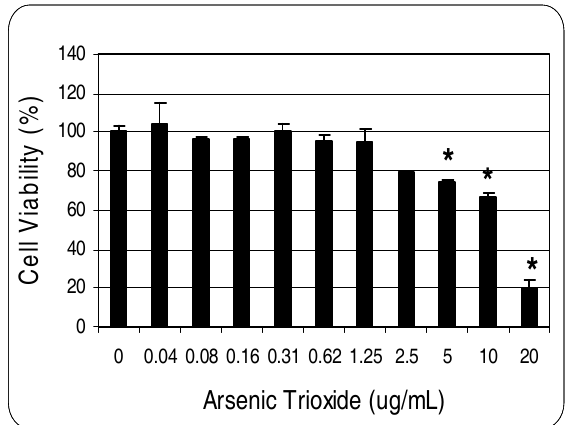
Figure 4: Time-response relationship with regard to the cytotoxicity of arsenic trioxide to human leukemia (HL- 60) cells. HL-60 cells were cultured with different doses of arsenic trioxide for 6, 12, and 24 hours respectively as indicated in the Materials and Methods. Cell viability was determined based on the MTT assay. Each point represents a mean ± SD of 3 experiments with 6 replicates per dose.